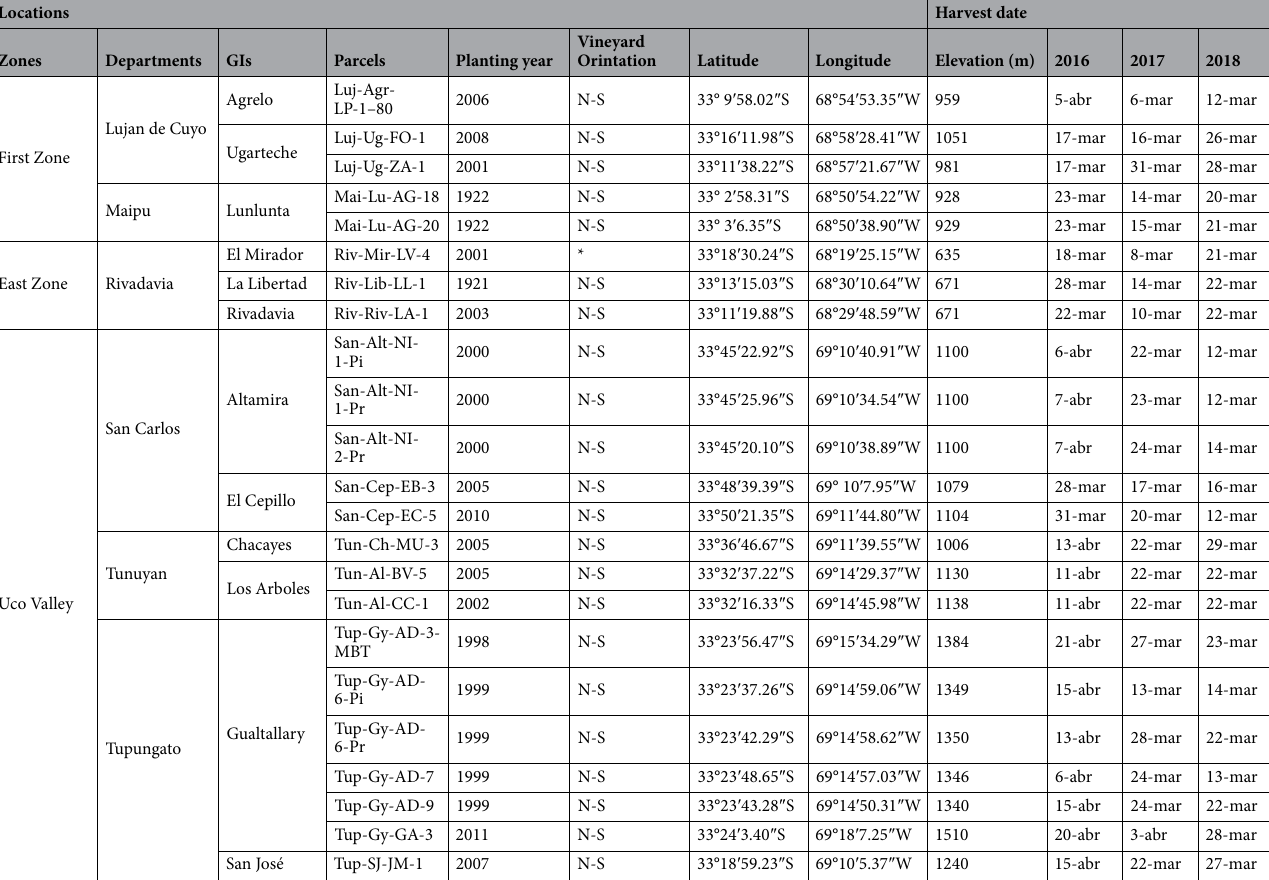
Table 1. Mendoza Malbec parcels